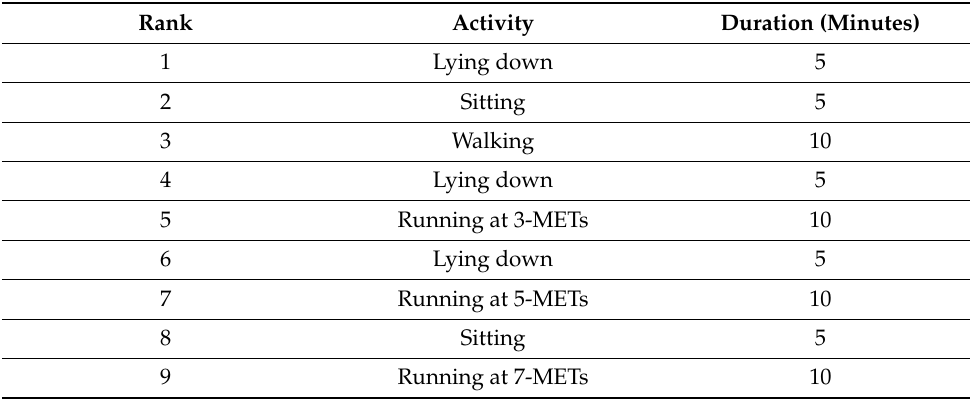
Table 2. Duration and order of activities performed by each